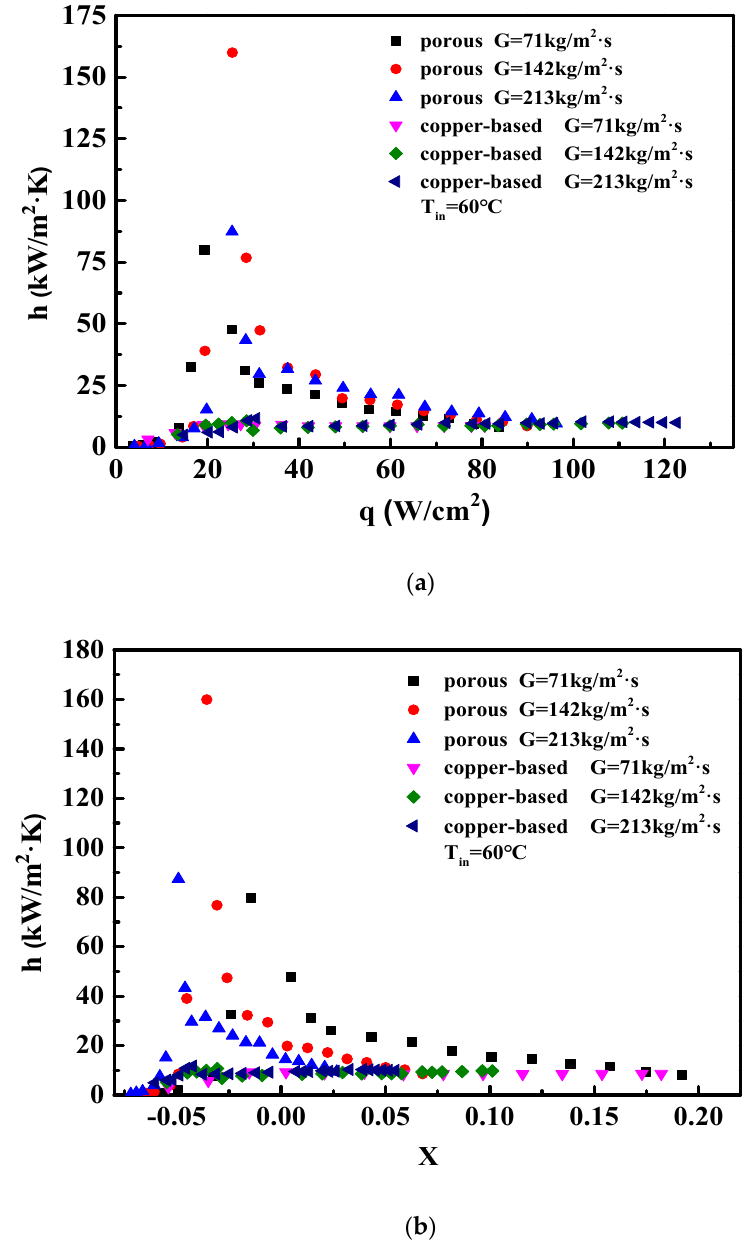
Figure 5. The heat transfer coefficient versus heat flux ( a ) and vapor quality ( b ) of porous microchannels and copper-based microchannels.